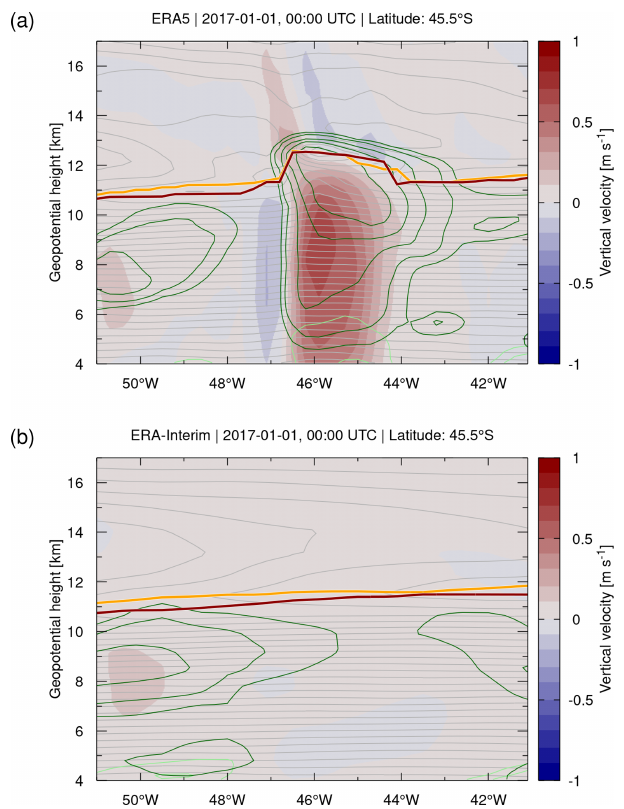
Figure 13. Vertical velocities (contour surface) of (a) ERA5 and (b) ERA-Interim reanalysis data on 1 January 2017, 00:00UTC. Light gray curves show temperature contours at levels of 2K. Also shown are the geopotential heights of the WMO first tropopause (red curves) and the dynamical tropopause as defined by the ± 3 . 5PVU contour (orange curves). Dark green and light green curves show contours of the cloud ice and liquid water content at levels of 0.01, 0.1, 1, and 10gkg − 1 , respectively.